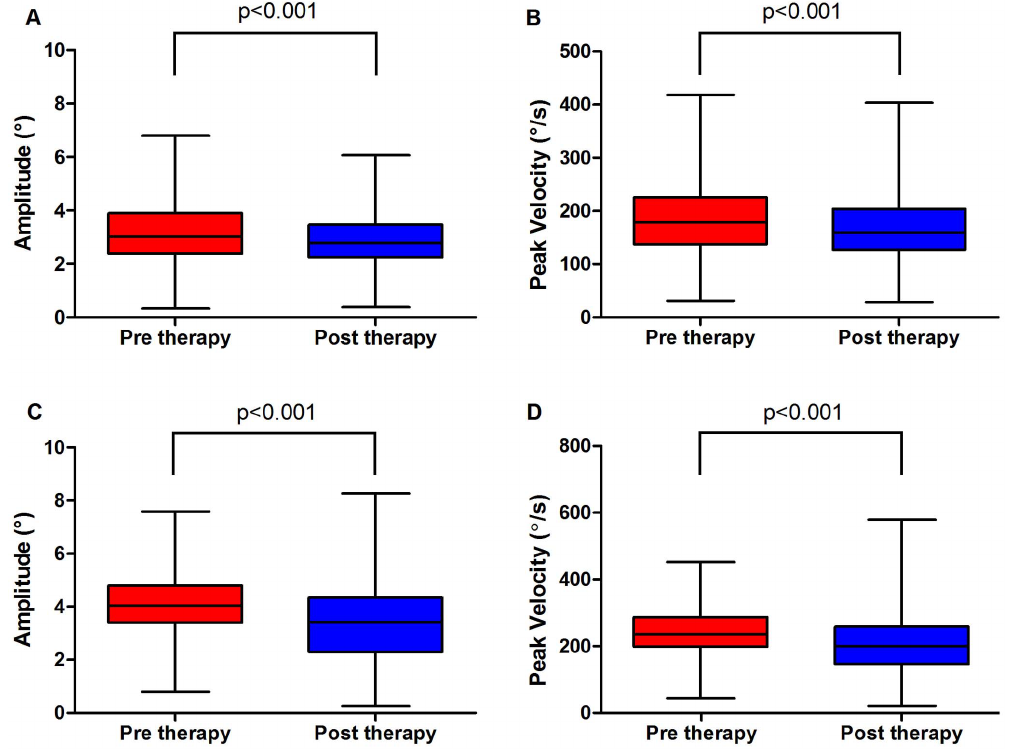
Figure 2. Box-whiskers of amplitude and peak velocity (pre vs post therapy). A–B: Variations of amplitude and peak velocity values of saccadic intrusions of Patient 1. C–D: Variations of amplitude and peak velocity values of Patient 2.